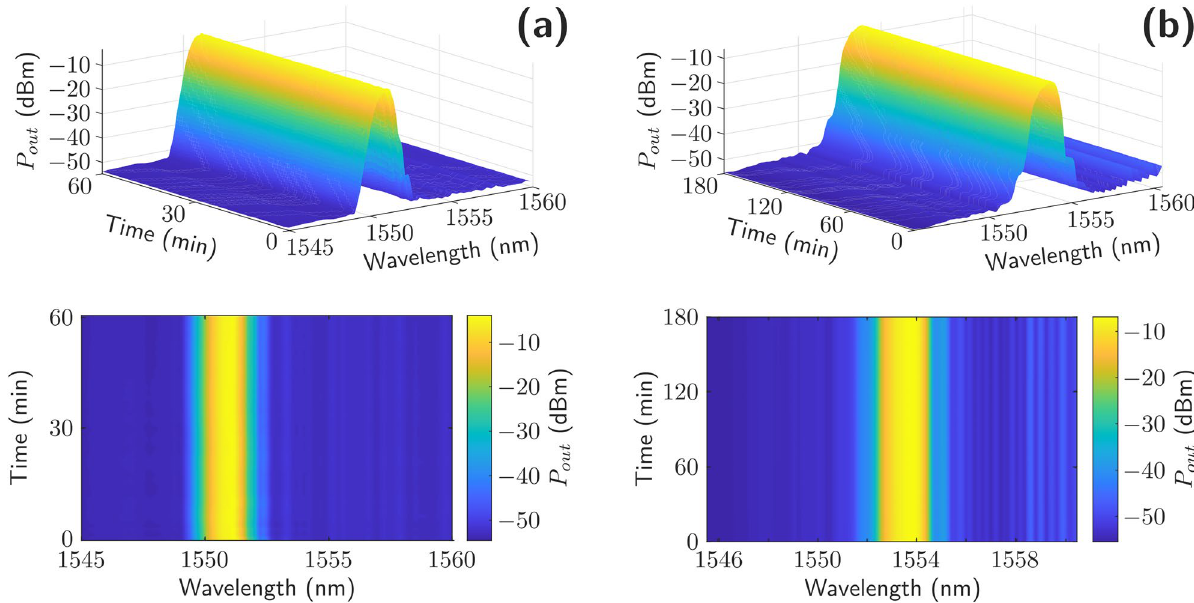
Figure 6. ( a ) Output power stability when pumped at 37.5 dBm by using FBGs ( a ) or chirped ACBFRs ( b ) as reflectors as a function of time. (MATLAB R2020b, surf and contourf commands for the upper and lower figures respectively. https:// es. mathw orks. com/ produ cts/ matlab.